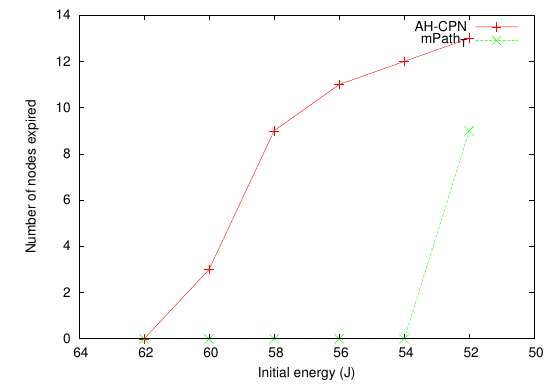
Figure 7. Network lifetime